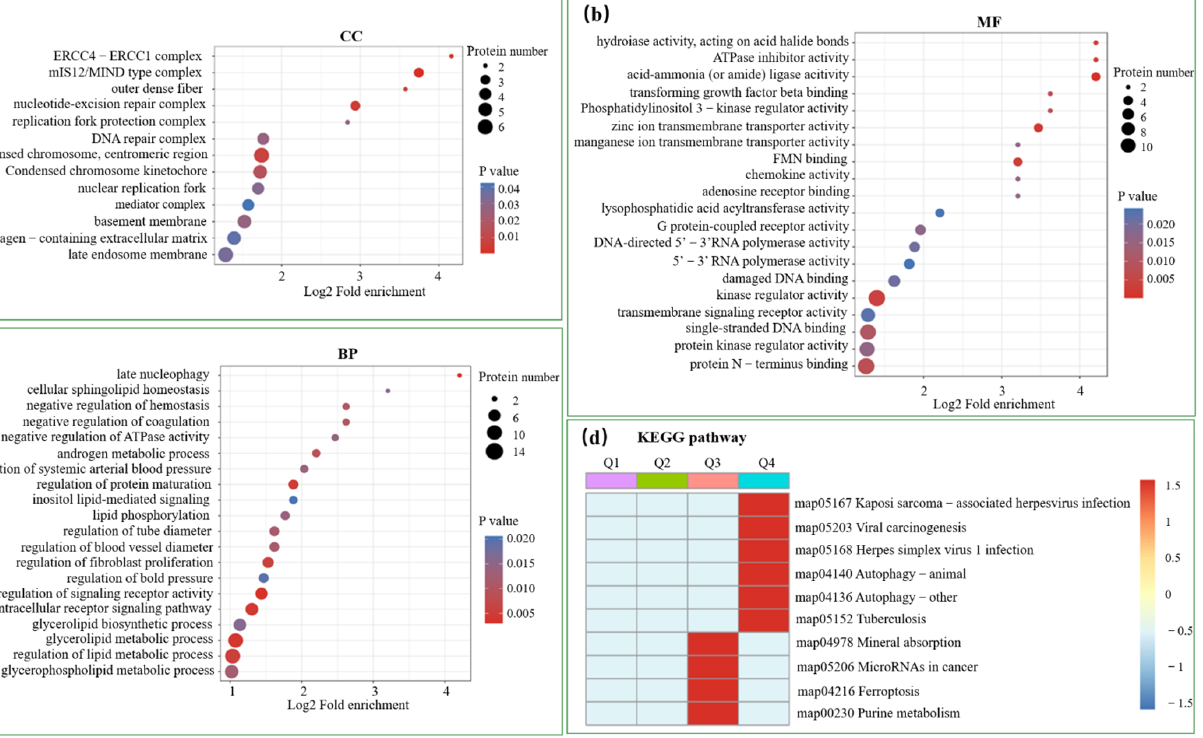
Figure 4. Functional enrichment analysis of DEPs based on GO and KEGG pathway. The vertical axis shows the top 20 enriched biological processes, and the horizontal axis represents the richness factor. The color and size of the dots represent the range of the p -value and the number of DEPs mapped to the indicated GO terms ( a – c ), respectively. A two-tailed Fisher’s exact test was employed to test the enrichment of the DEPs against all identified proteins. p -value < 0.05 was considered significant. ( d ) Analysis of the significant differences in the KEGG pathway showed that DEPs were mostly grouped in the Q3 and Q4 categories. Q Category: Q1 (<0.769), Q2 (0.769–0.833), Q3 (1.2–1.3), and Q4 (>1.3).